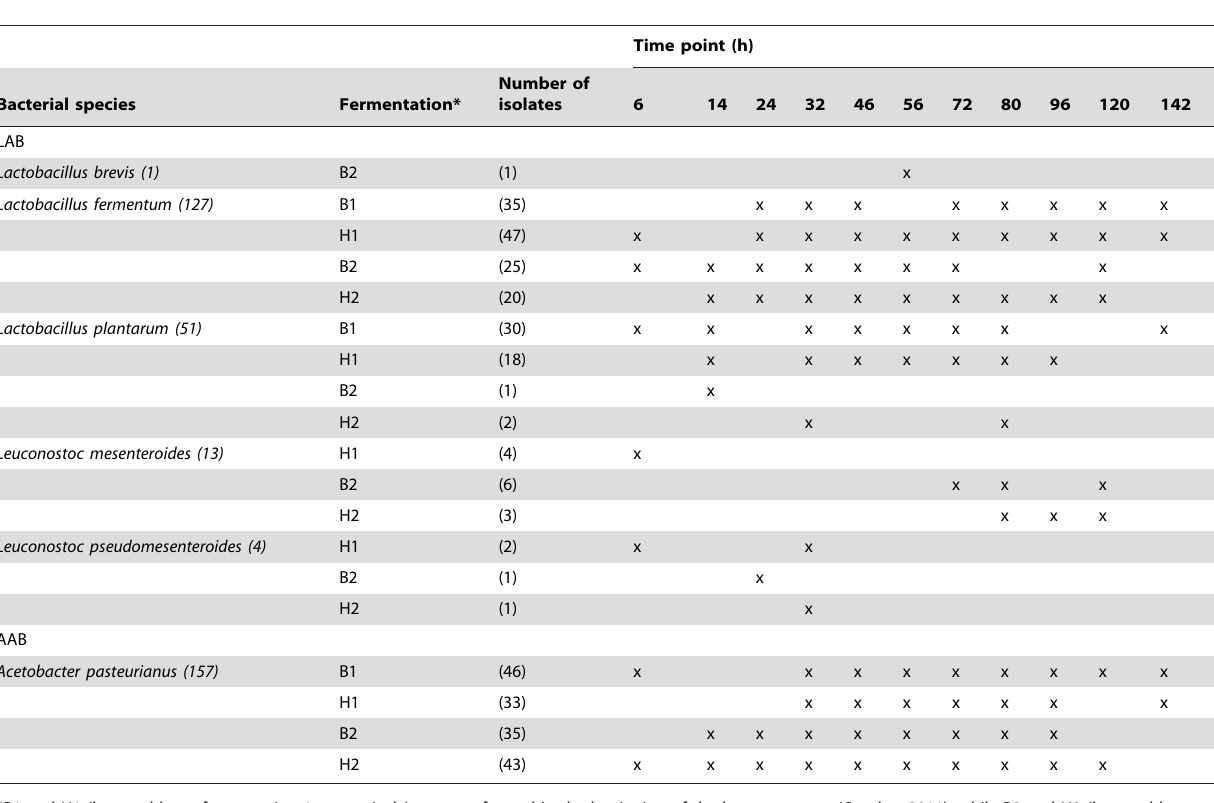
*B1 and H1 (box and heap fermentation 1 respectively) were performed in the beginning of the harvest season (October 2011), while B2 and H2 (box and heap fermentation 2 respectively) were executed at the end of the harvest season (January